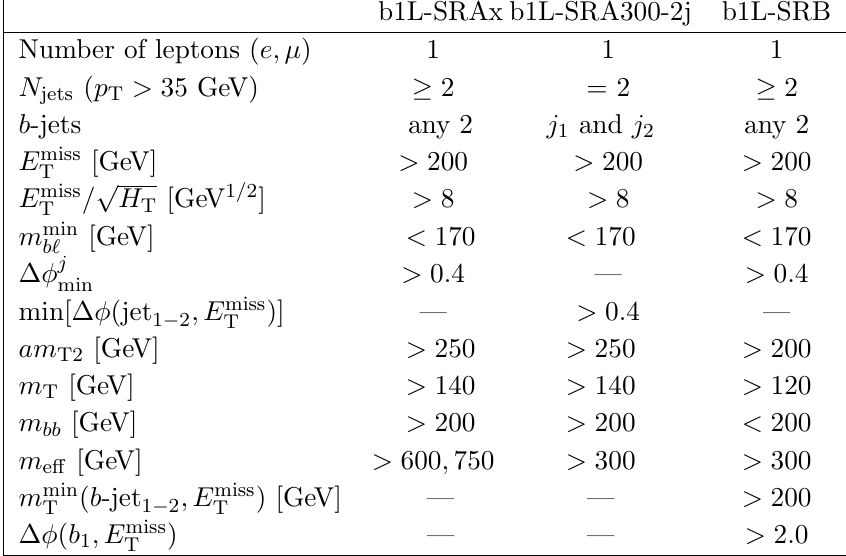
Table 2. Summary of the event selection in each signal region for the one-lepton channel. For SRA, the \x" denotes the m e(cid:11) selection used. The term lepton is used in the table to refer to signal electrons and muons. Jets ( j 1 , j 2 ) are labelled with an index corresponding to their decreasing order in p T